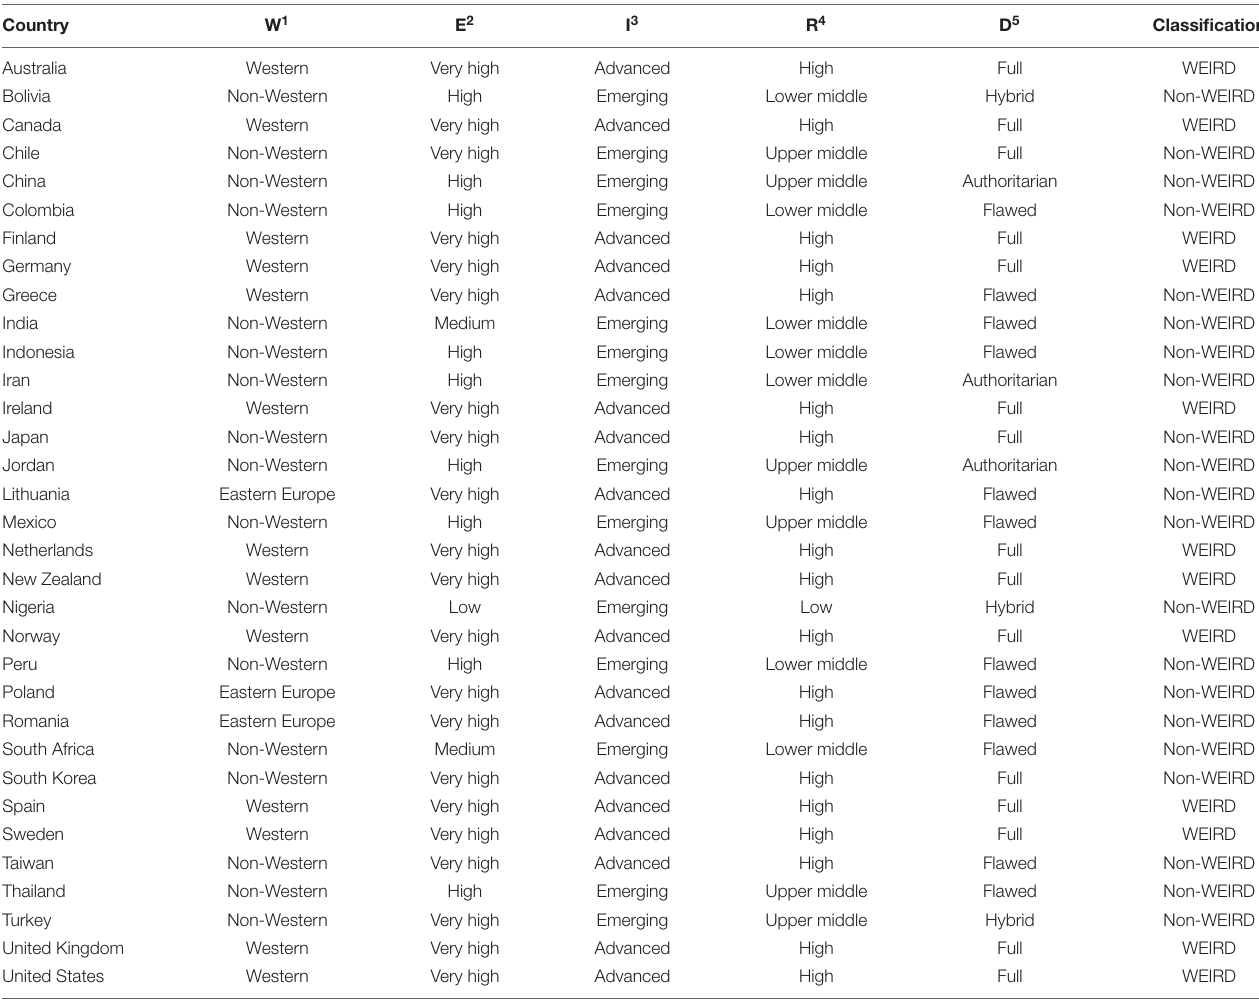
TABLE 1 | Description of WEIRD parameters by country and